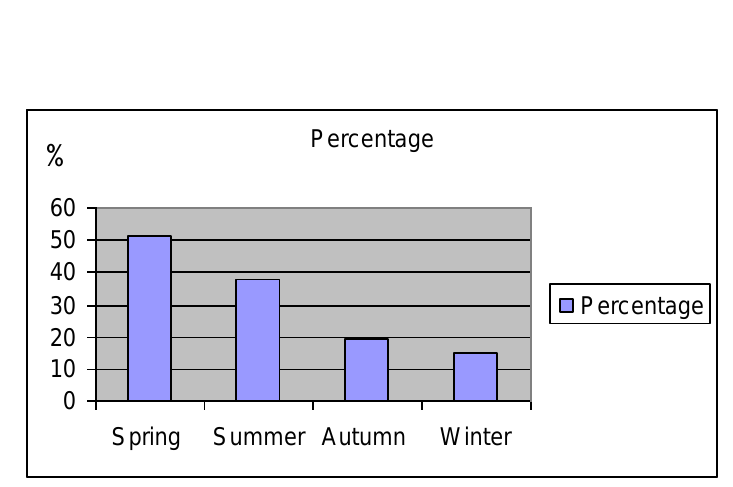
Figure(1) : Infection rates with E. histolytica during seasons of